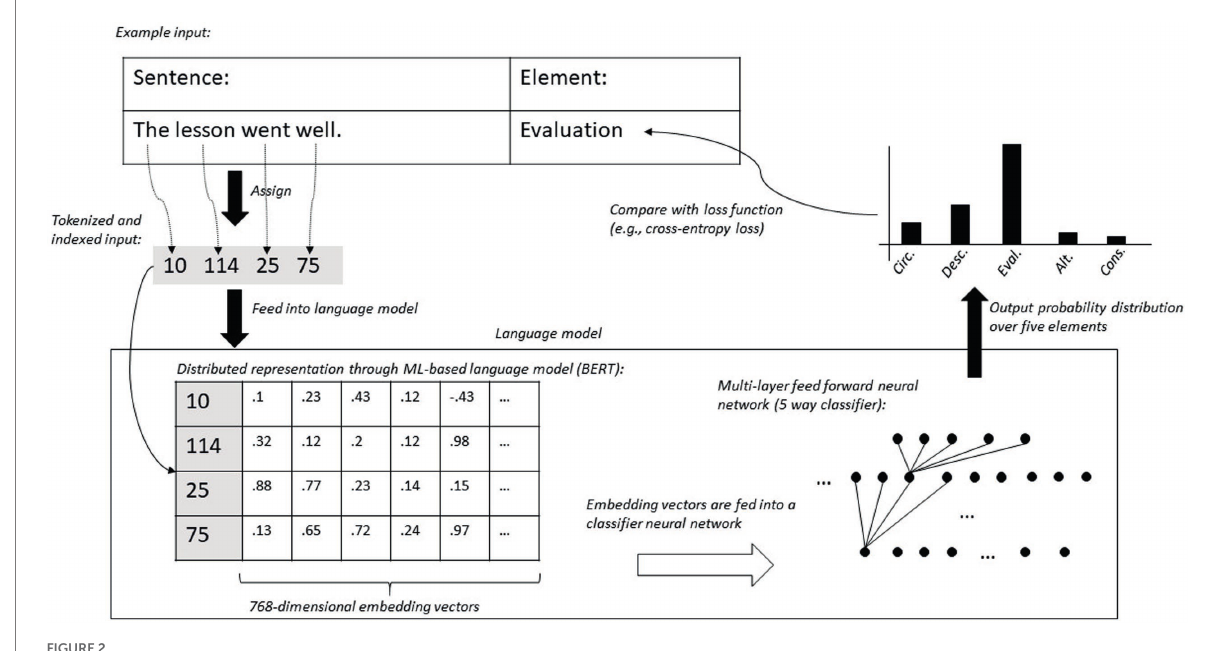
FIGURE 2 Detailed representation of the classification pipeline for the ML-based probalistic language